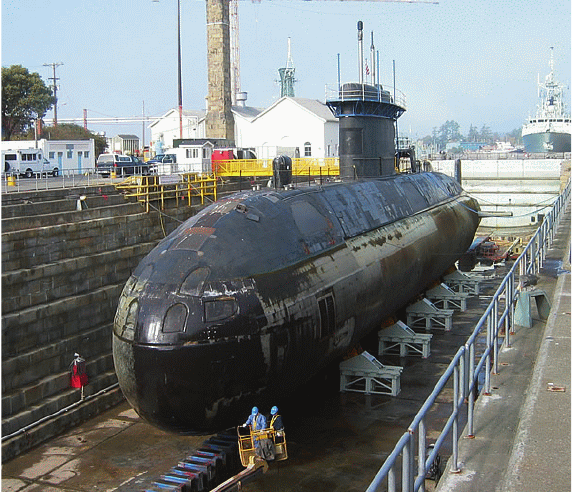
Figure 1: The HMCS Victoria, one of Canada ’ s four Victoria-class submarines, shown in dry dock (Department of National Defence photo).